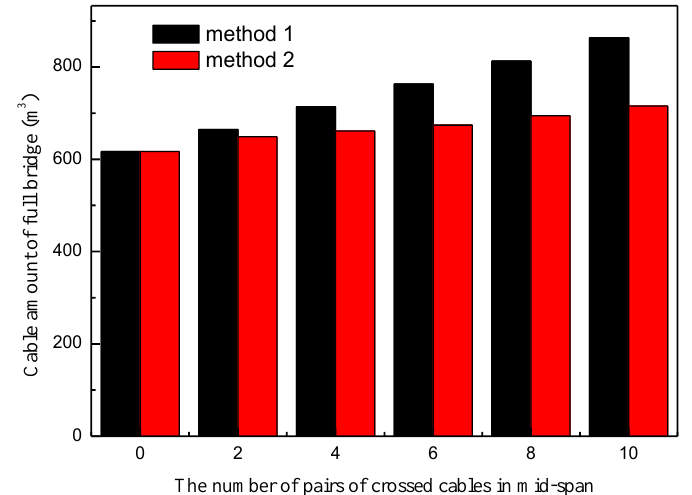
Figure 10. Comparison of the consumption of the cables.